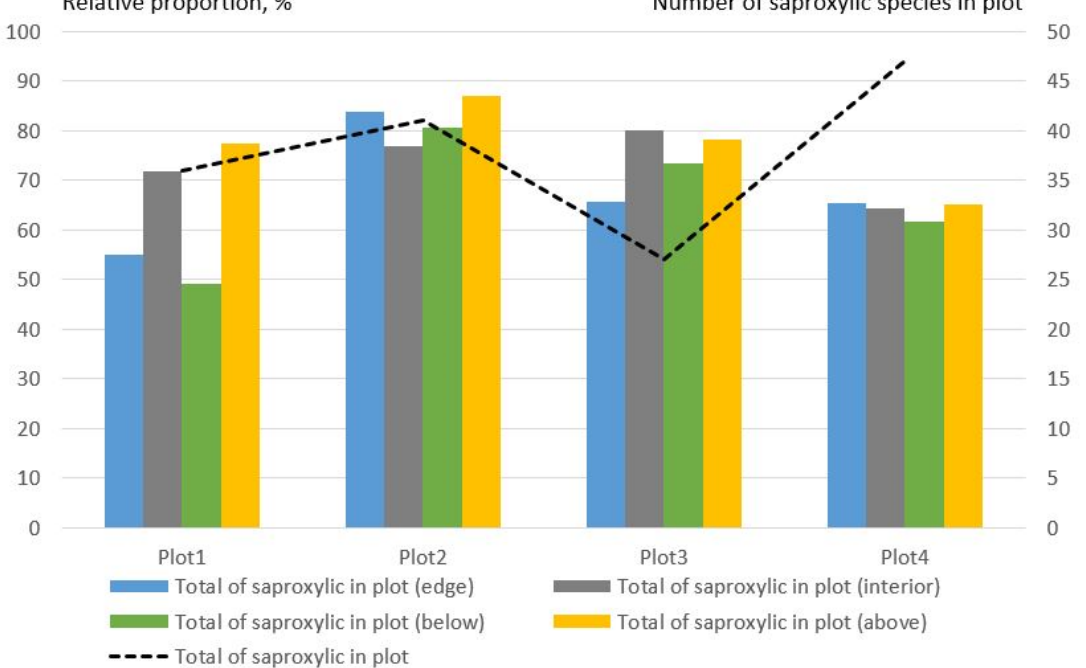
Figure 4. The relative proportion of saproxylic Coleoptera species collected using beer traps on the edges and in the forest interior (% of the number of species in the plot).